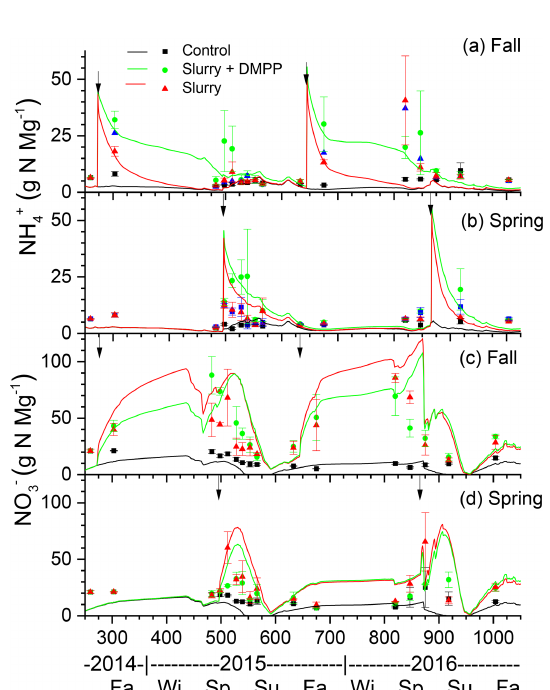
Figure 2. Soil NH + and NO − concentrations measured (symbols) 4 3 and modelled (lines) at 0–10cm depth following applications of dairy slurry without and with DMPP. Arrows indicate dates of ap- plication. (Fa – fall; Wi – winter; Sp – spring; Su –